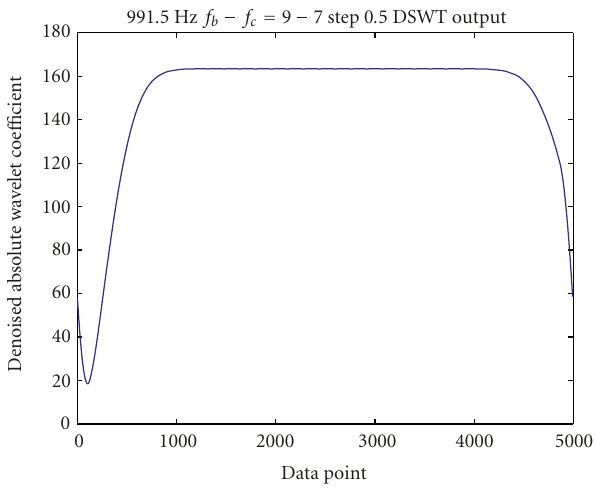
Figure 7: Coe ffi cients generated by discrete stationary wavelet transform (Haar wavelet, level 5 decomposition) of the absolute wavelet coe ffi cients plot in Figure 6.